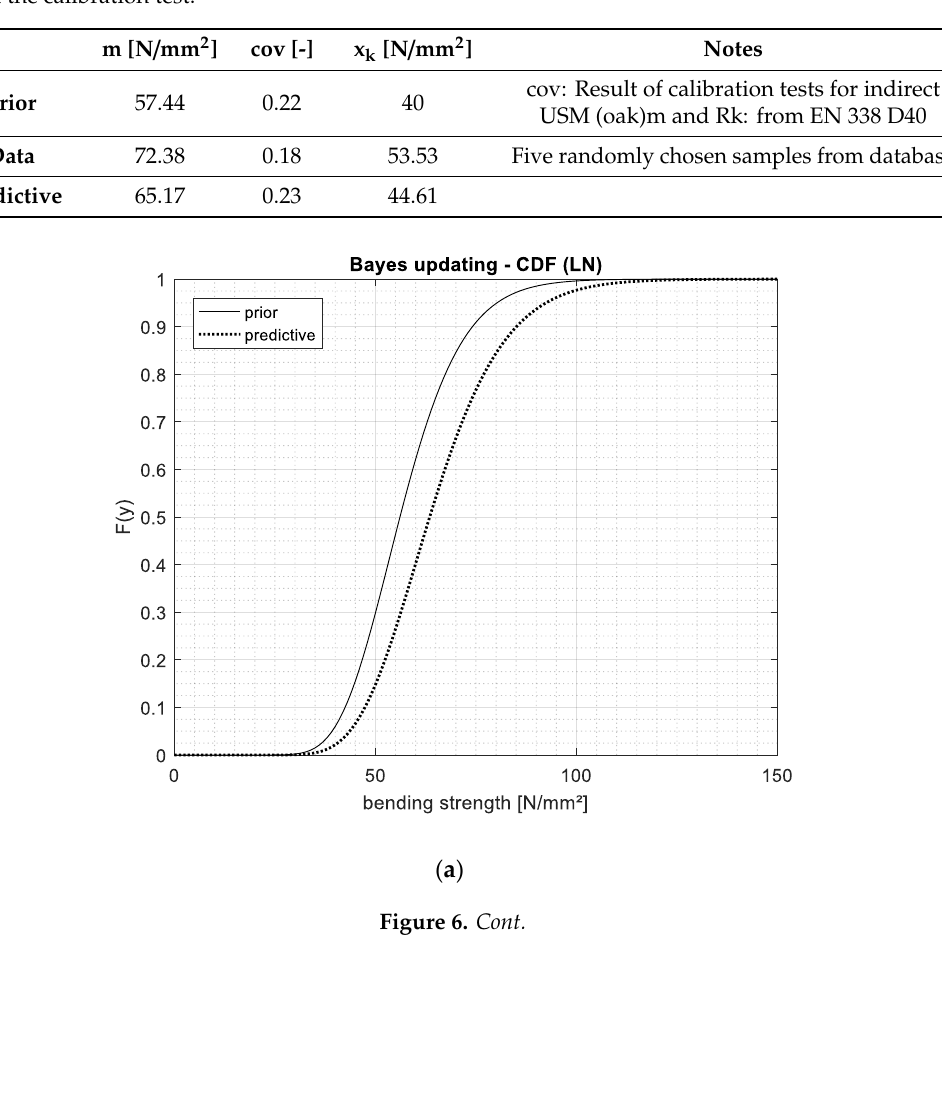
Table 4. Exemplary Bayesian updating of bending strength based on the oak samples – prior model from the calibration test.